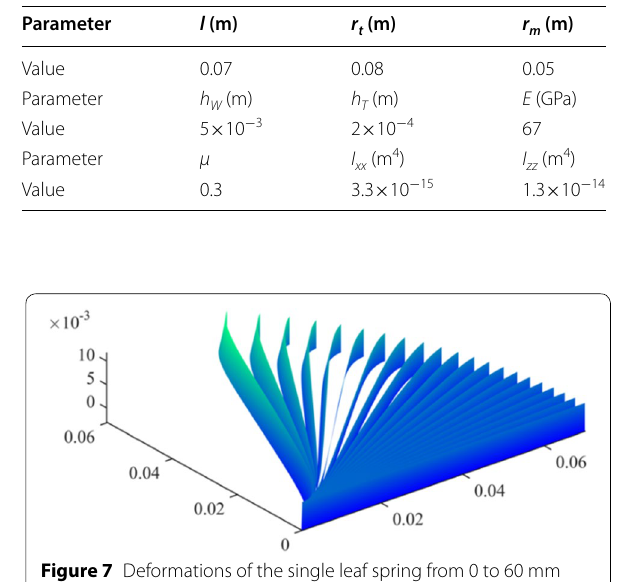
Table 1 Lengths and mechanical properties of the leaf springs